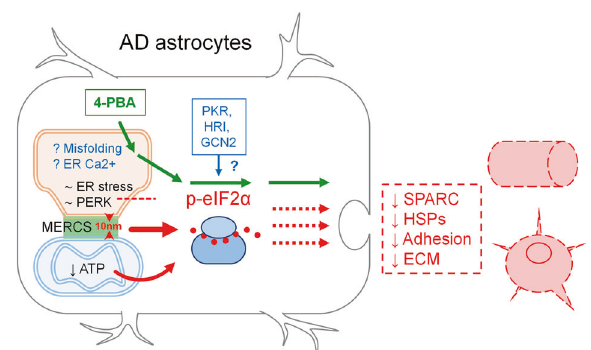
Fig. 10 Schematic representation of the role of impaired proteins synthesis in the loss of homeostatic functions by AD astrocytes. Phosphorylation of eIF2 α and reduction of protein synthesis in AD astrocytes occurs without induction of overt ER stress/UPR and activation of PERK ( ∼ ER stress, ∼ PERK and intermittent red line). A role of PKR, HRI and GCN2 kinases is to be determined (blue arrow and question mark). Alteration of ER-mitochondrial interaction could be a plausible candidate (10 nm, red arrowheads and red thick arrow), as well as a reduced ATP supply by mitochondria (curved red arrow). A role of protein misfolding and ER Ca 2 + dyshomeostasis is hypothesized (? Misfolding, ? ER Ca 2 + ). The deregulation of proteins synthesis may potentially result in impaired secretion (red inter- mittent arrows) of neurotrophic and neuroprotective molecules as well as impaired formation of extracellular matrix (SPARC, heat shock proteins (HSPs), Adhesion, ECM). Protein synthesis, p-eIF2 α levels and homeostatic functions can be rescued by the chemical chaperone 4-PBA (green arrows).